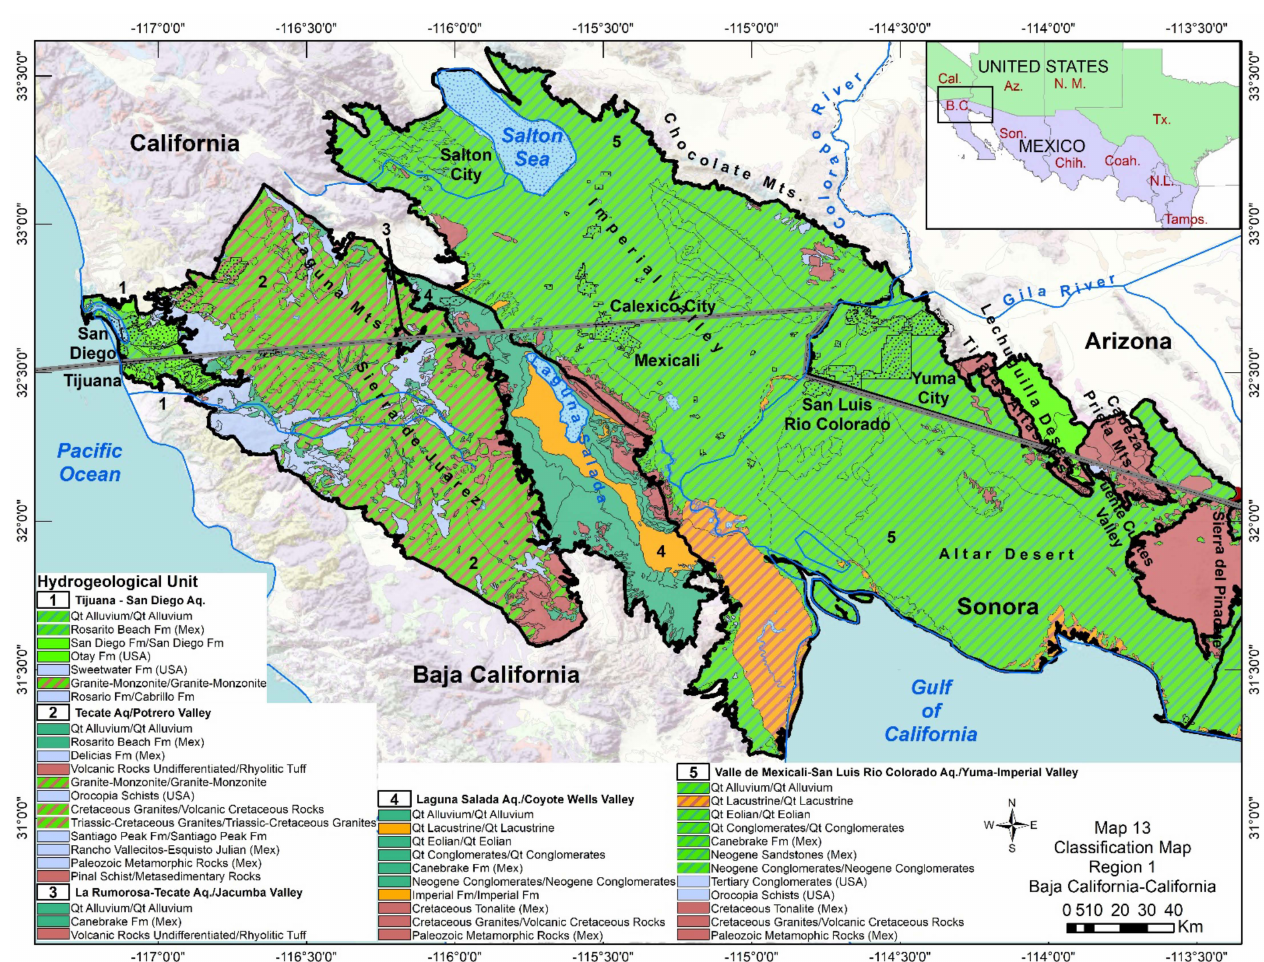
Figure 13. Classification map, Baja